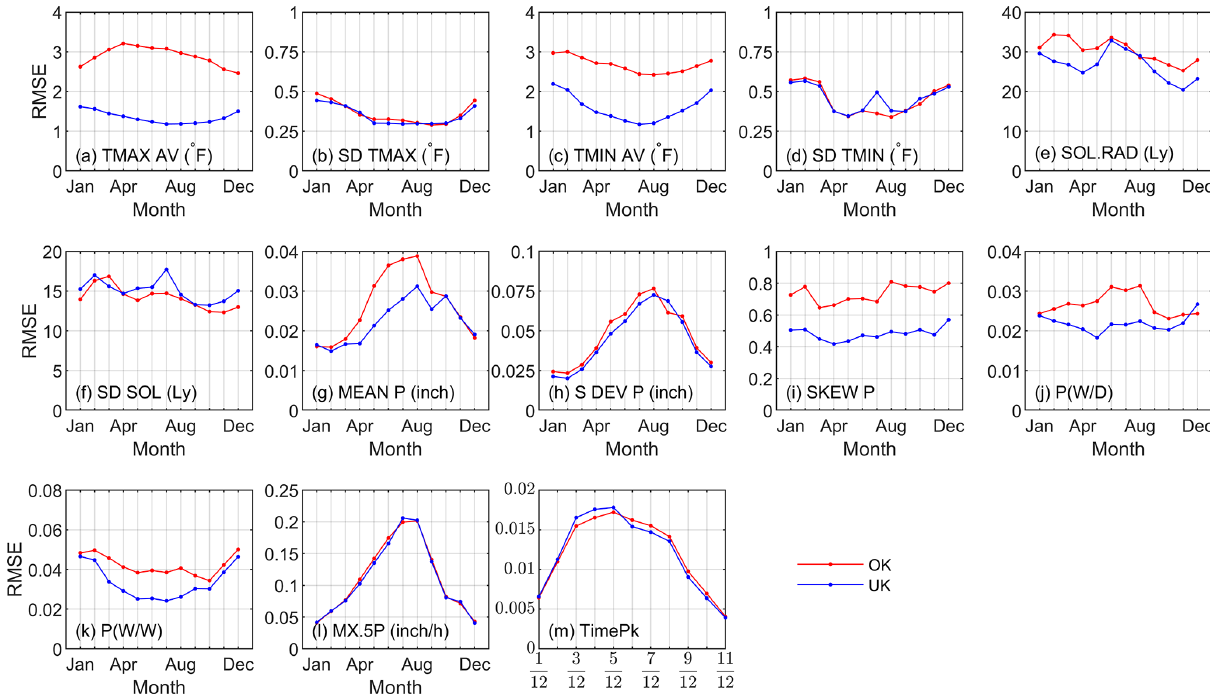
Figure 6. Comparison of the interpolation quality in terms of the root mean square error (RMSE) using ordinary kriging (OK) and universal kriging (UK) for temperature, solar radiation, and precipitation